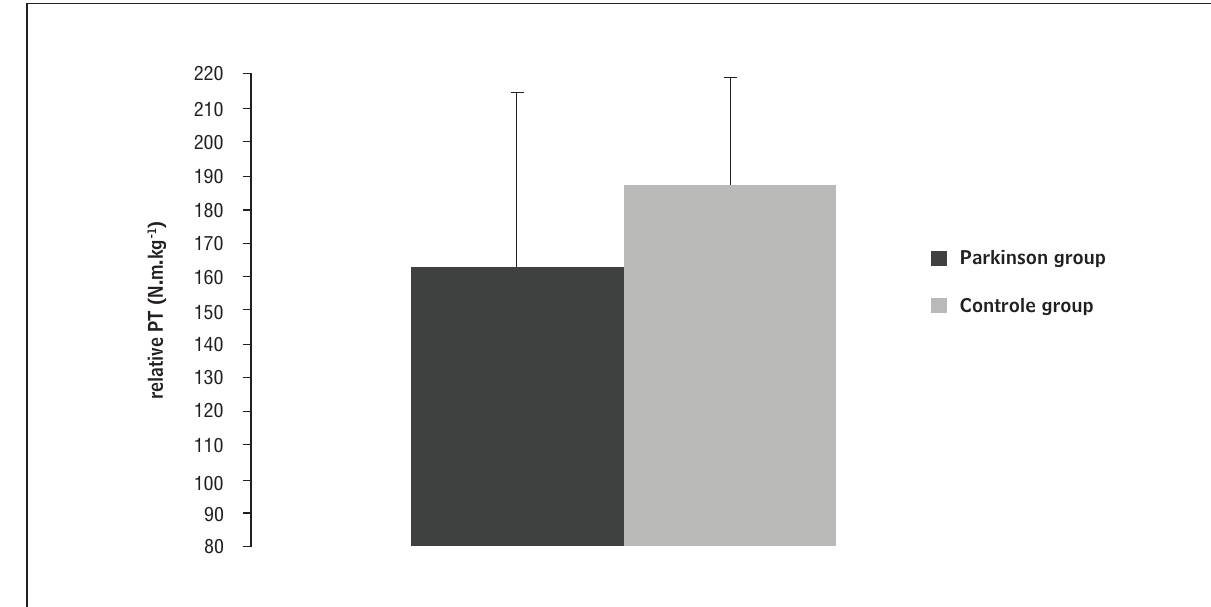
Graph 2 - Relative peak torque (relative PT) in the groups under assessment Source: Research